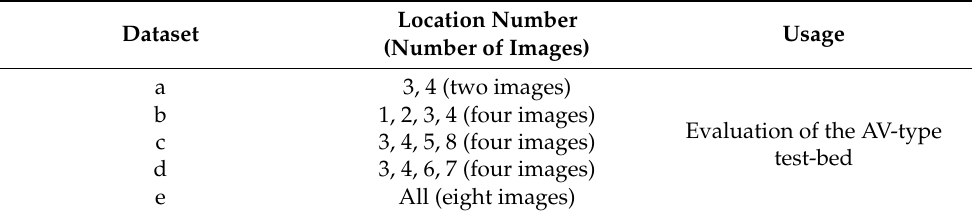
Table 2. Five different simulation datasets utilized.